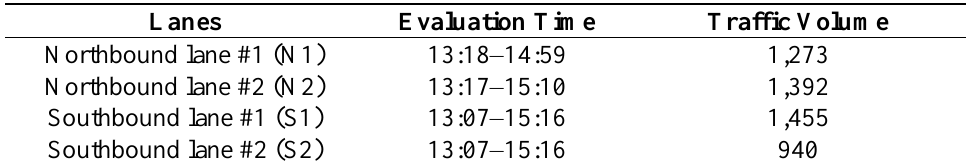
Table 5. Evaluation durations and traffic volume.